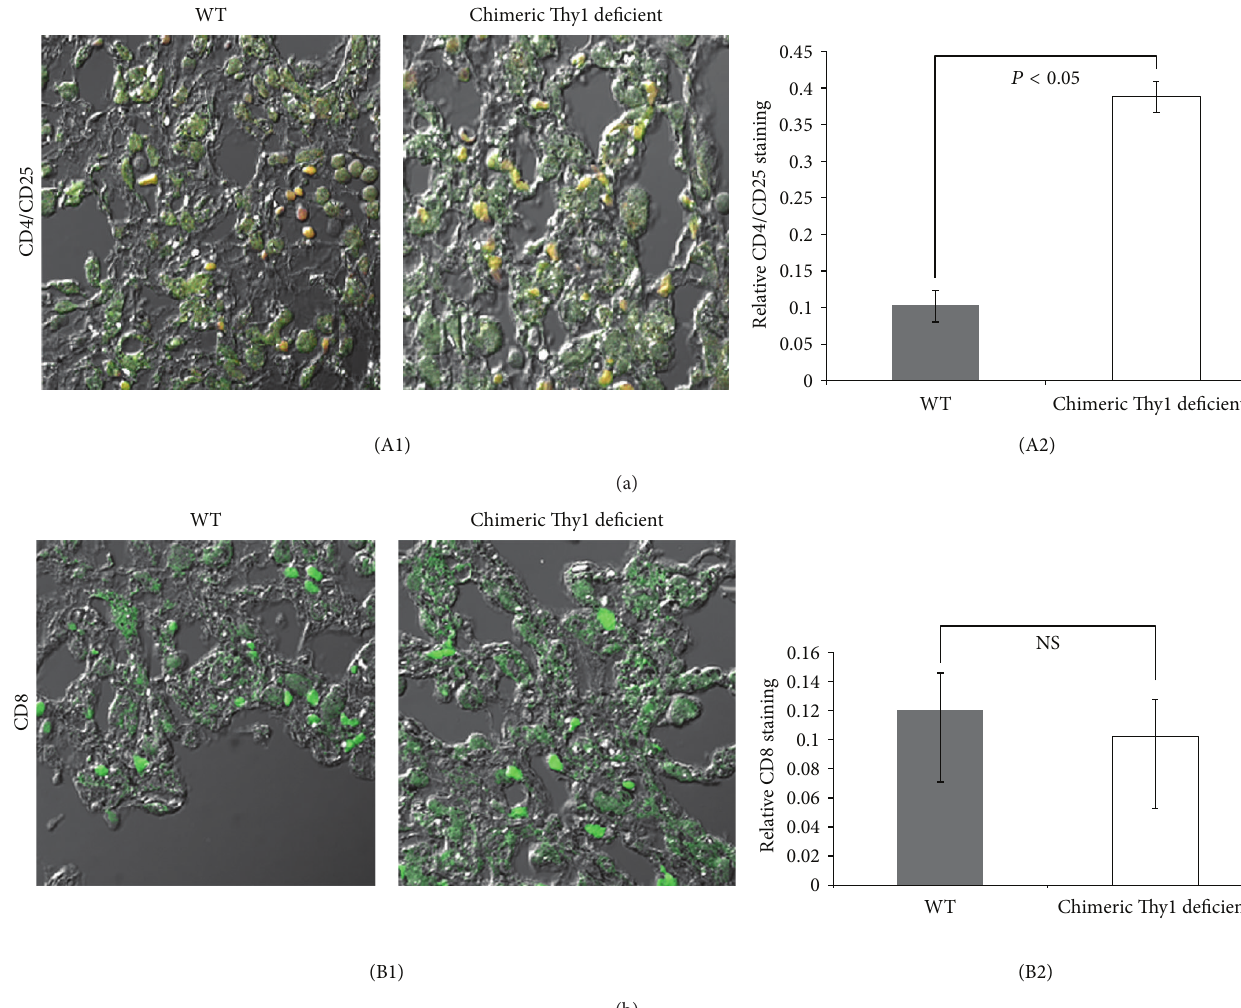
Figure 4: Assessment of the T cell population following bleomycin intratracheal instillation (IT) in wild-type mice (WT) (control) with Thy1 + lymphocytes and Thy1 + myofibroblasts, and chimeric Thy1-deficient mice with Thy1 + lymphocytes and Thy1 − myofibroblasts. Chimeric Thy1-deficient mice were created by total body irradiation (750 rad) of Thy1-deficient mice, followed by transplantation with WT Thy1 + lymphoid cells. For comparison, wild-type (WT) mice were irradiated and had adoptive transfer with Thy1 + (WT) lymphoid cells. (A1 and A2) Immunofluorescence of CD4 + /CD25 + , and (B1 and B2) CD8 staining of mouse lung sections 14d following IT bleomycin in chimeric Thy1-deficient mice (empty bars) and control WT mice (grey bars). N 6 = 5 WT and 8 chimeric Thy1-deficient. (A1) Nomarski microscopy pictures of CD4/CD25 (yellow) ( ∗ 𝑃 < 0.05 ), and (B1) CD8 (green) staining are presented. (A2 and B2) 10 fields of every immunofluorescence slide were digitized and semiquantitatively analyzed using the Ariol system. The relative staining ratio represents the ratio between numbers of stained and unstained cells in a certain analyzed are. The results were similar in 2 different